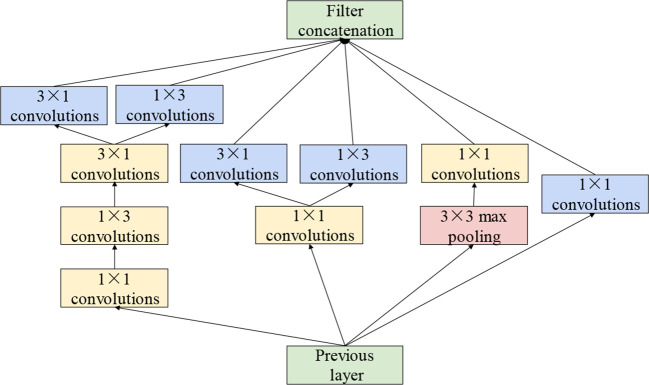
Inception structure.